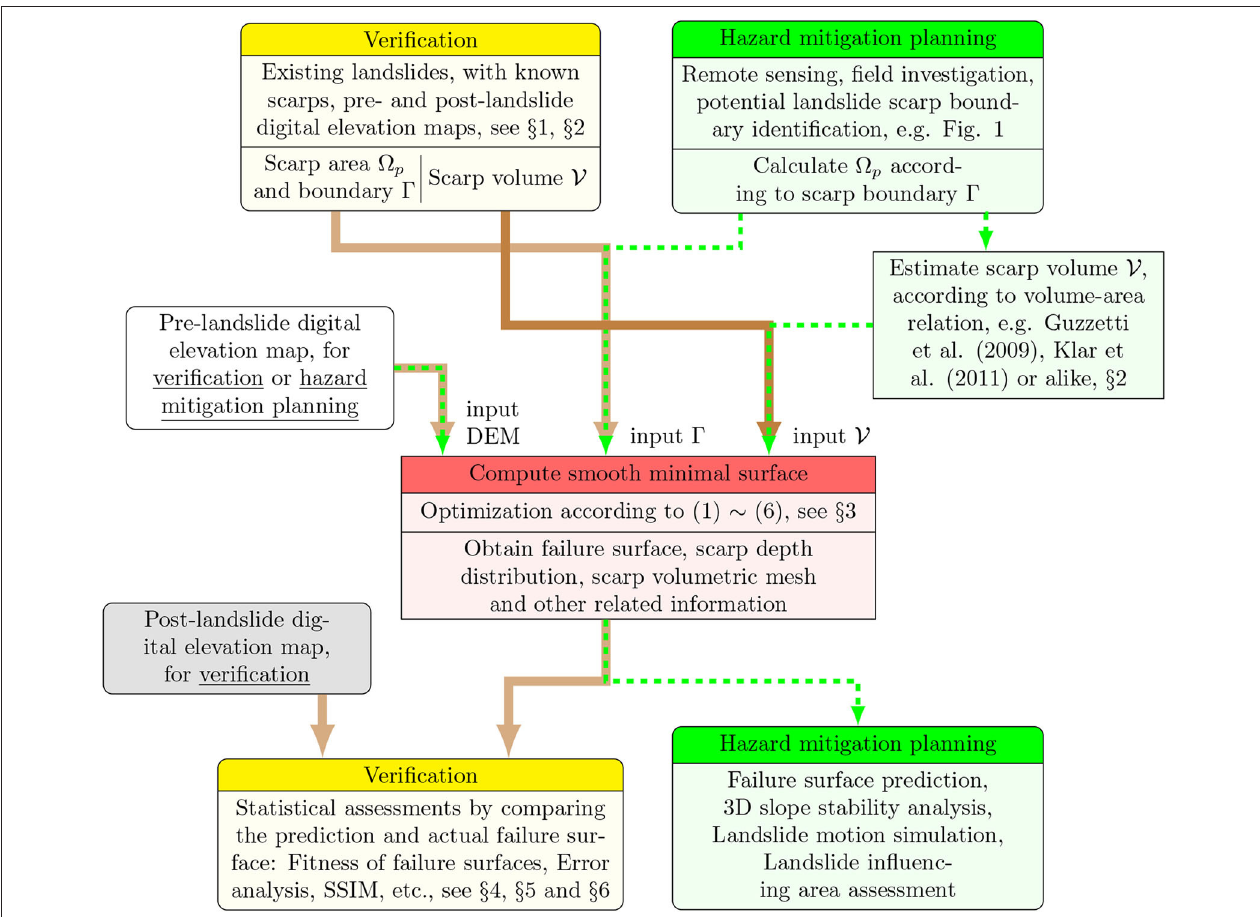
FIGURE 13 | Flowchart of the present model for both application scenarios: verification, blocks shaded in light yellows, and hazard mitigation planning, blocks in light greens. The current failure surface prediction model is in light red colors. For failure surface prediction verification, i.e., the main theme of the paper, the computational flow is led by the thick solid brown lines but, for hazard mitigation planning, it is led by the thin dashed green